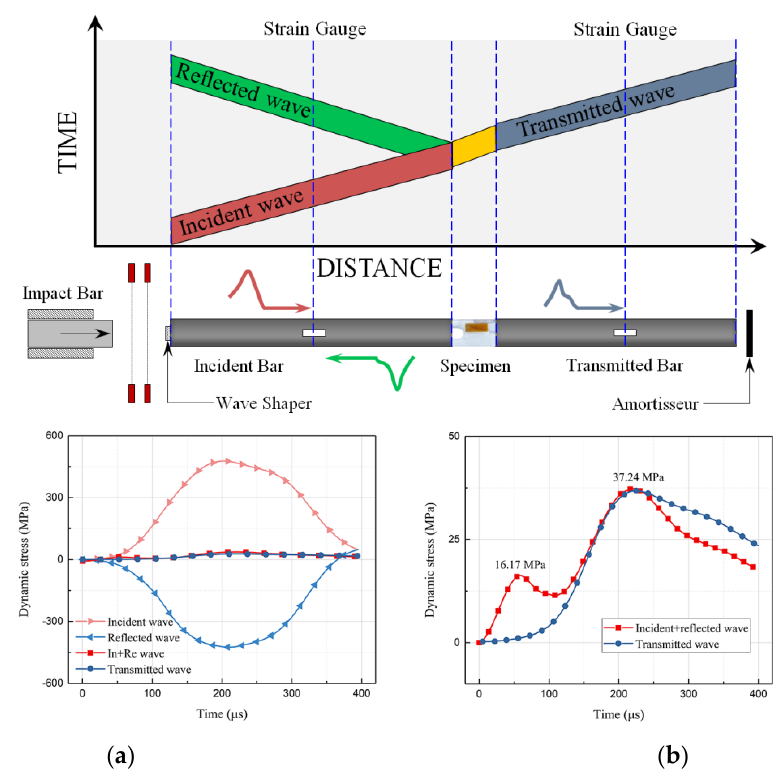
Figure 4. Dynamic stress waves in the experiment. ( a ) Dynamic stress waves of the Bars. ( b ) The historical stress waves of the specimen.